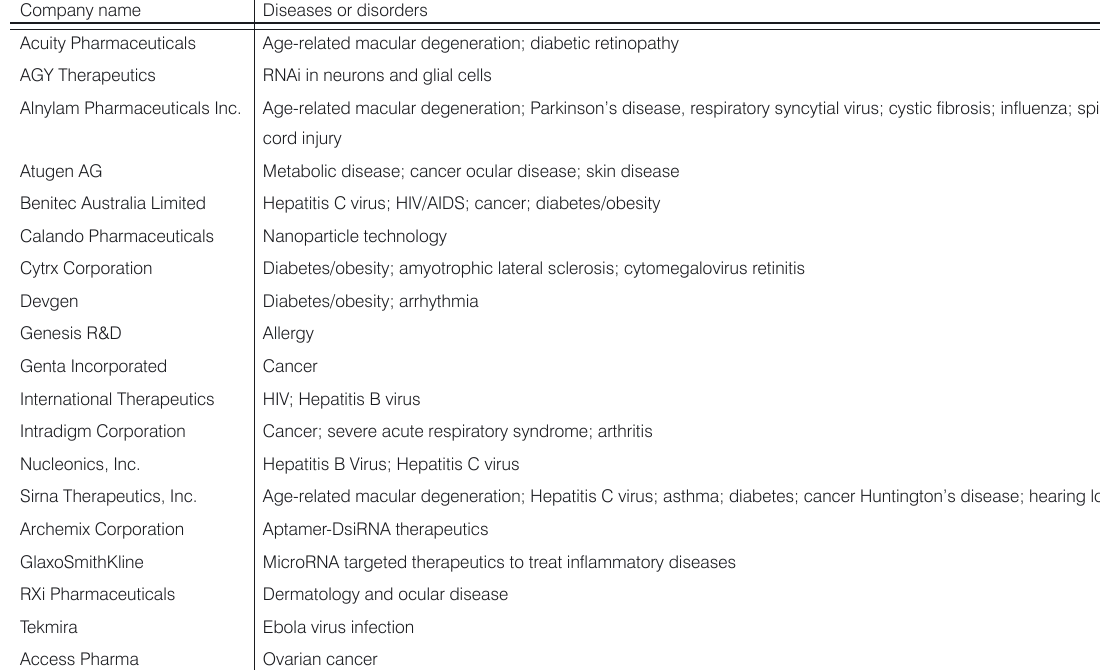
Table 2. Companies engaged with RNAi therapeutics